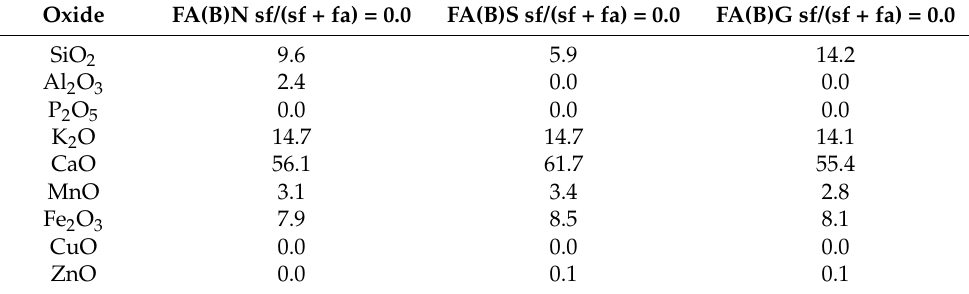
Table 8. Chemical Oxide Composition of Sieved and Ground Biomass Fly Ash Compared with untreated Fly